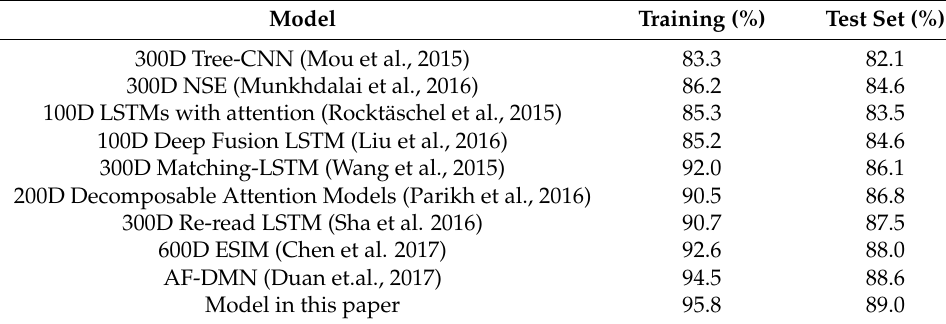
Table 4. Accuracy of each model on SNLI